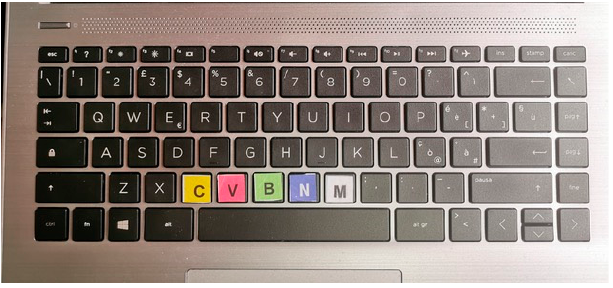
Figure 1. Study design.